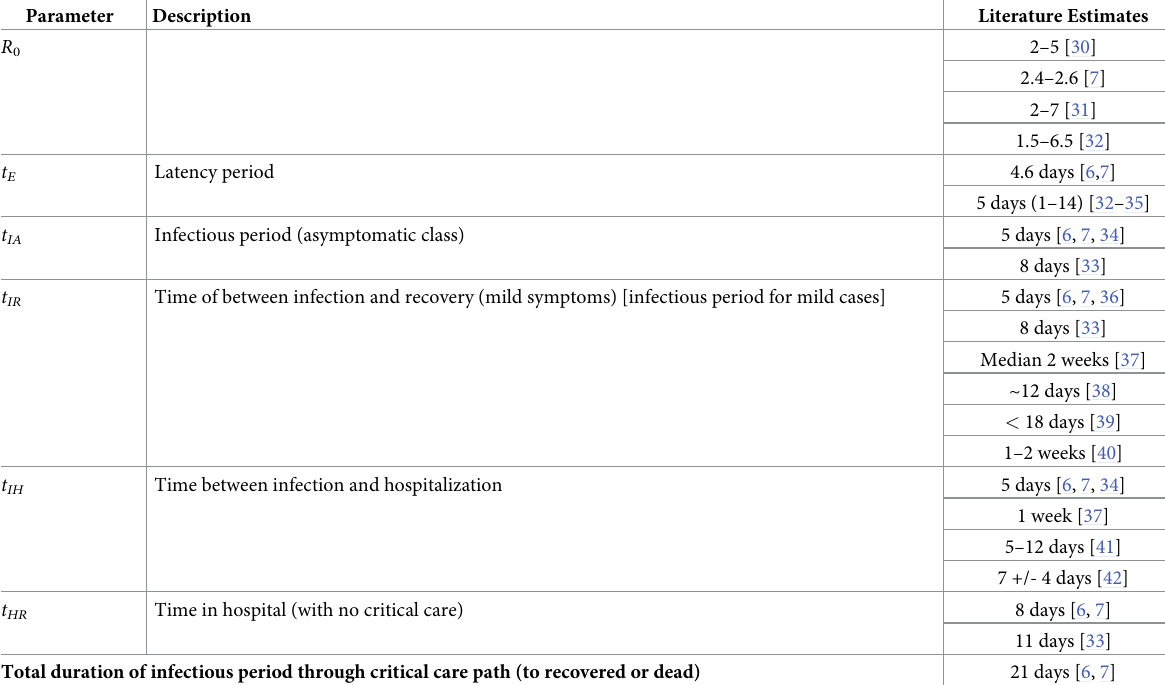
Table 1. Parameter estimates for the